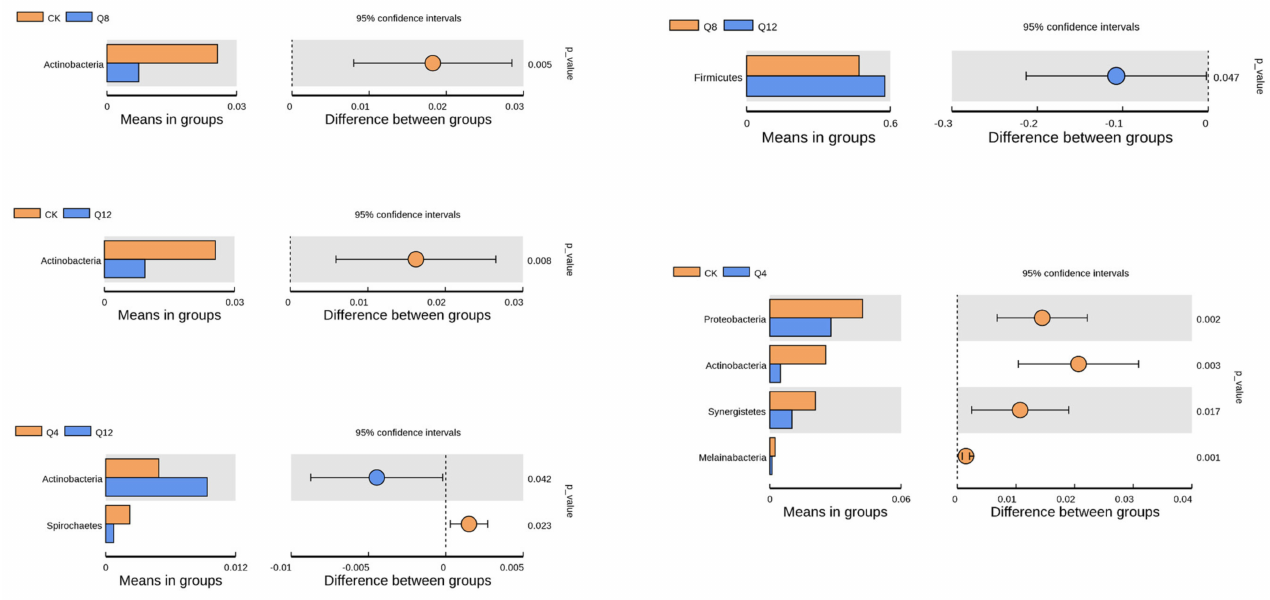
Figure 3. Analysis of species difference between phylum level T -test